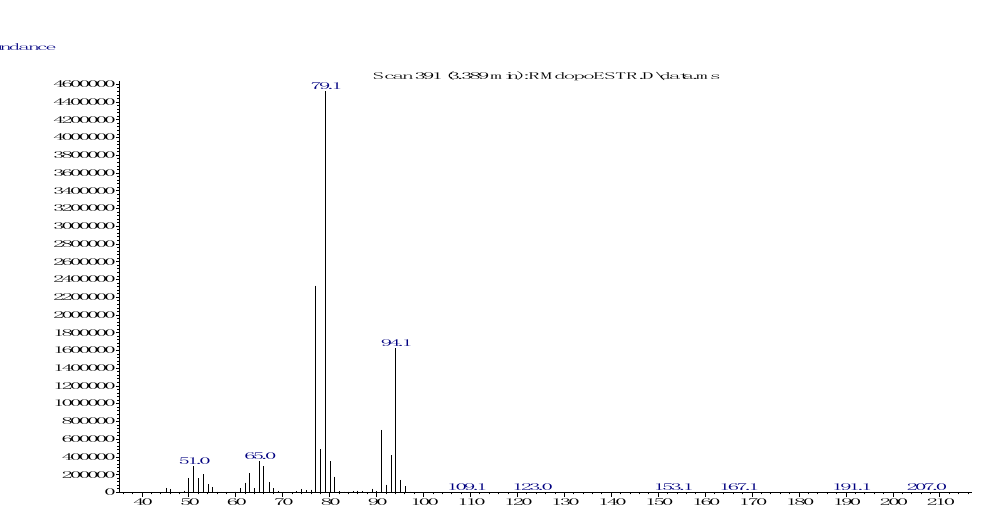
Figure A1. MS spectrum of 4-ethylidene-1-cyclopentene, r.t 3.39 min.